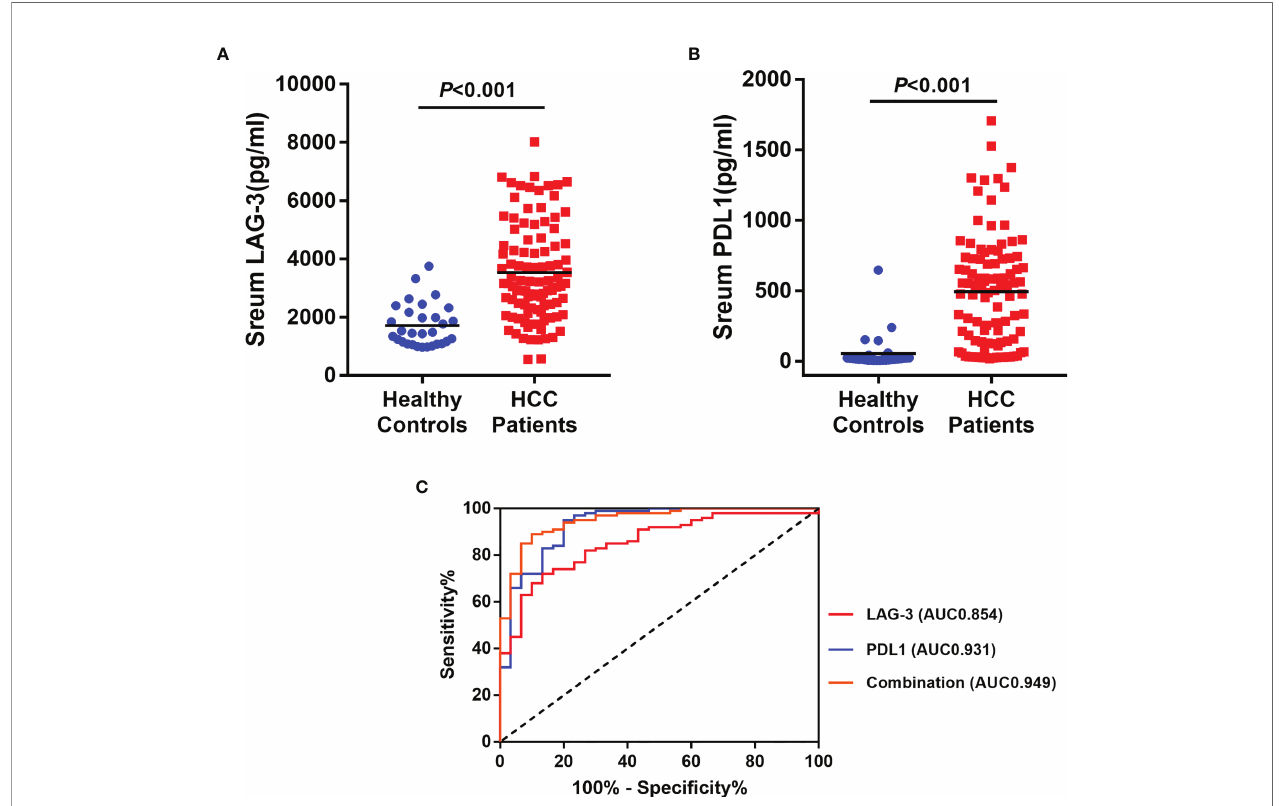
FIGURE 1 | Diagnostic signi fi cances of serum LAG-3 and PD-L1 in HCC patients underwent TACE. (A) Serum LAG-3 level was elevated in patients underwent TACE. (B) Serum PD-L1 level was elevated in patients underwent TACE. (C) ROC curve analysis of LAG-3, PD-L1 and combination of LAG-3 and PD-L1 differentiating HCC patients from healthy controls. HCC, hepatocellular carcinoma; TACE, Transarterial chemoembolization; ROC, receiver operating characteristics; AUC, area under